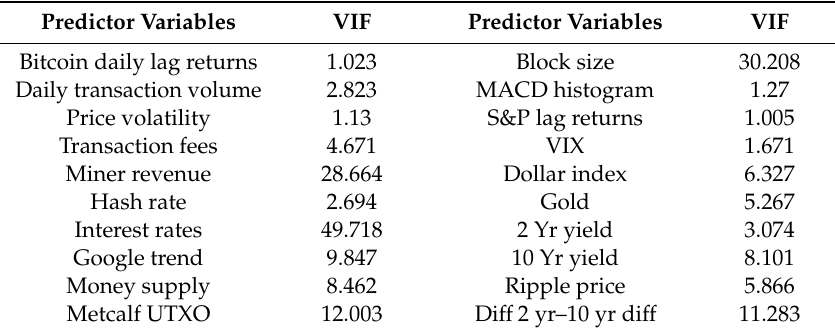
Table 1. Variance inflation factor (VIF) for predictor